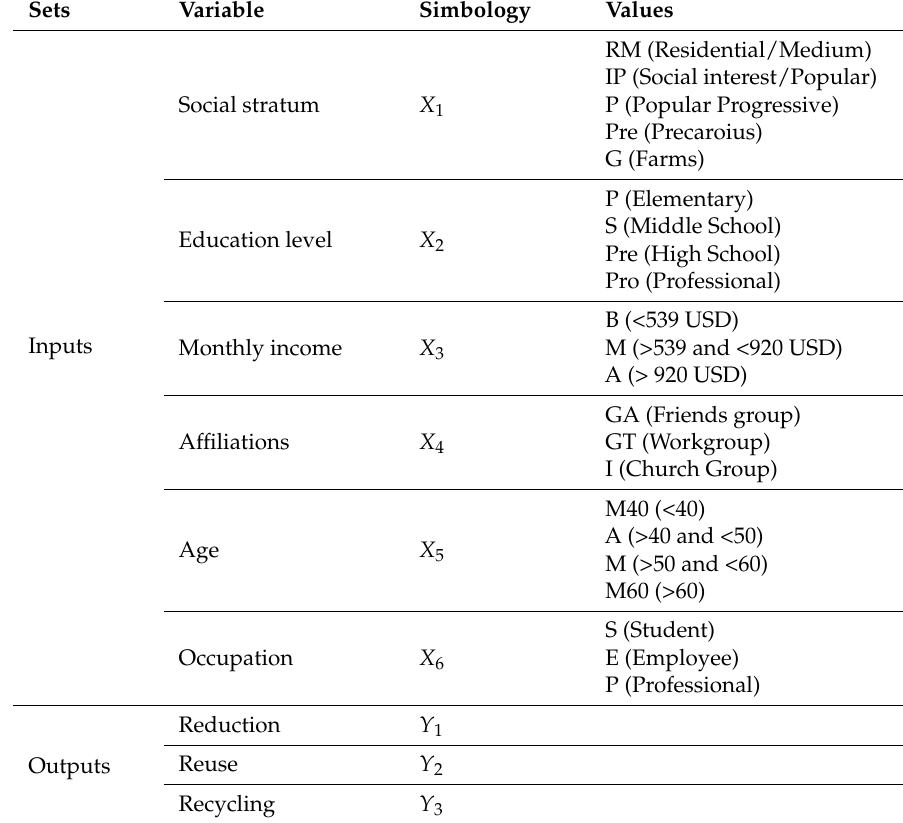
Table A1. Variables definition for fuzzy